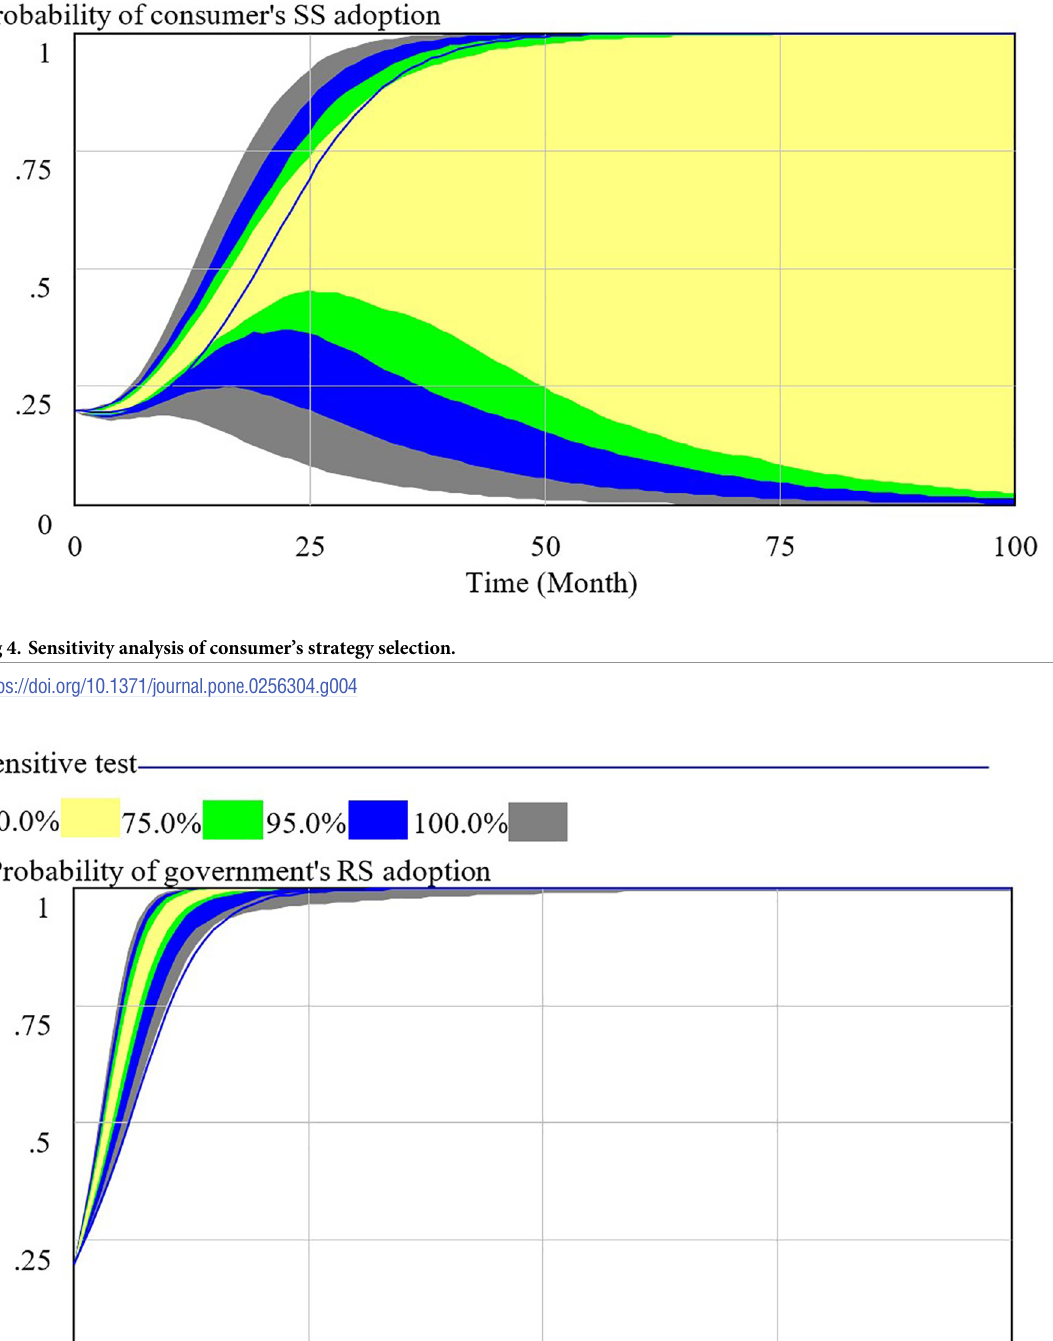
PLOS ONE | https://doi.org/10.1371/journal.pone.0256304 September 8,